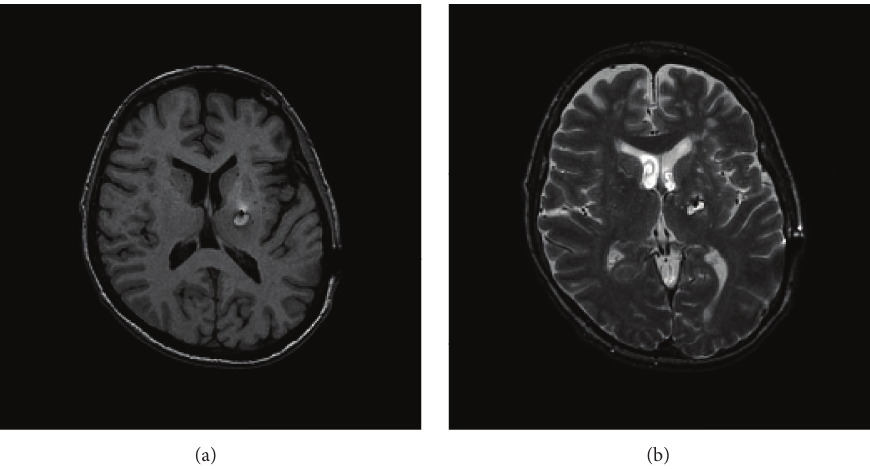
Figure 2: (a) An MRI brain confirmed a small resolving hematoma at the tip of the lead. (b) An MRI brain confirmed a small resolving hematoma at the tip of the lead. Table 1: Comparison of various etiologies of symptomatic bradycardia and